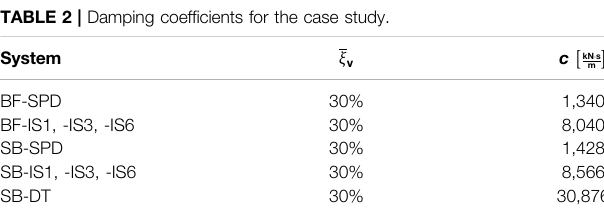
TABLE 2 | Damping coef fi cients for the case